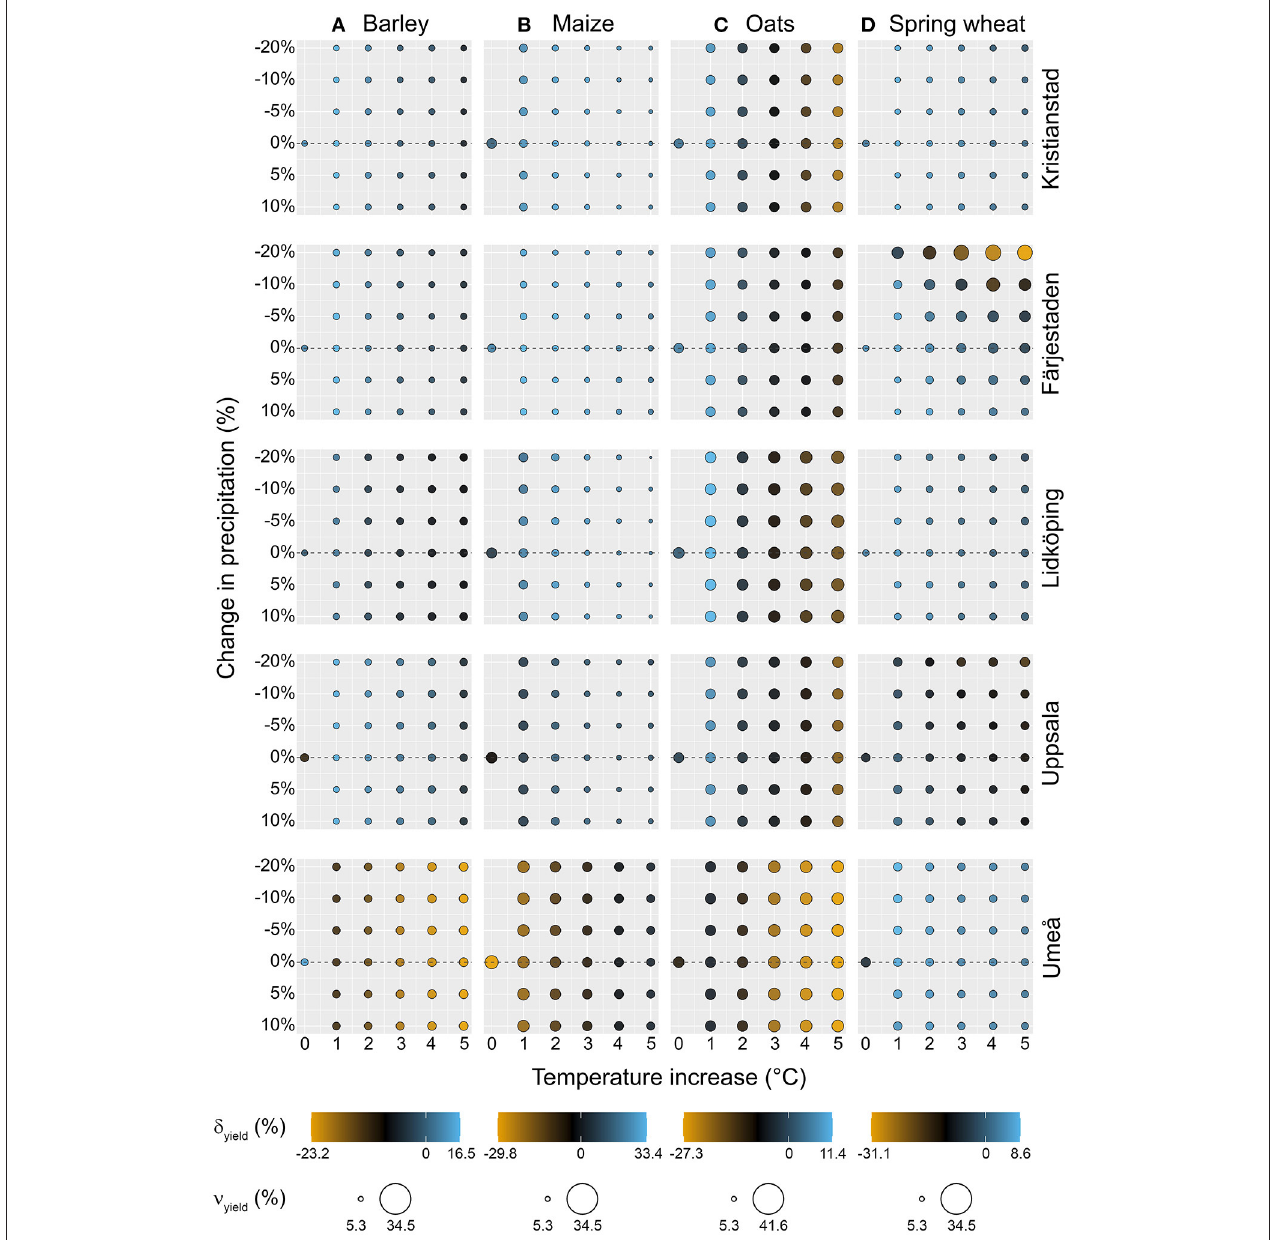
FIGURE 2 | Changes in crops yields for the five locations of the study. Brown colors indicate a decrease in yield while blue colors indicate an increase in yield. The size of the points indicates the variability of the yield (coefficient of variation). The dashed line indicates a 0% change in precipitation. The yield reference value (0%) was computed as the mean of the baselines of the five locations. ν yield : yield variability. δ yield : yield change. (A) Barley, (B) Maize, (C) Oats, and (D) Spring